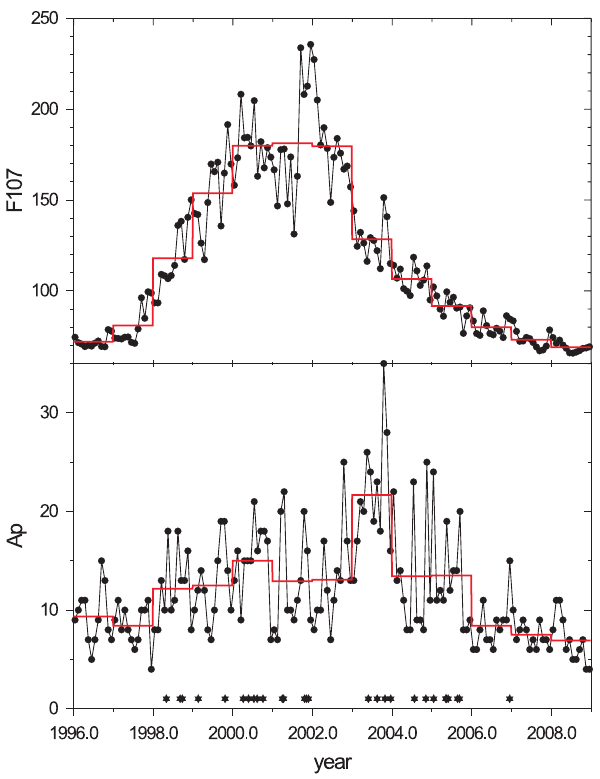
Fig. 1. Variation of the solar activity index F107 (upper part) and of the planetary geomagnetic activity index Ap (lower part), both based on monthly mean values (black) and yearly mean values (red). Geomagnetic disturbances with daily values Ap ≥ 80 are marked in the lower part by black asterisks.